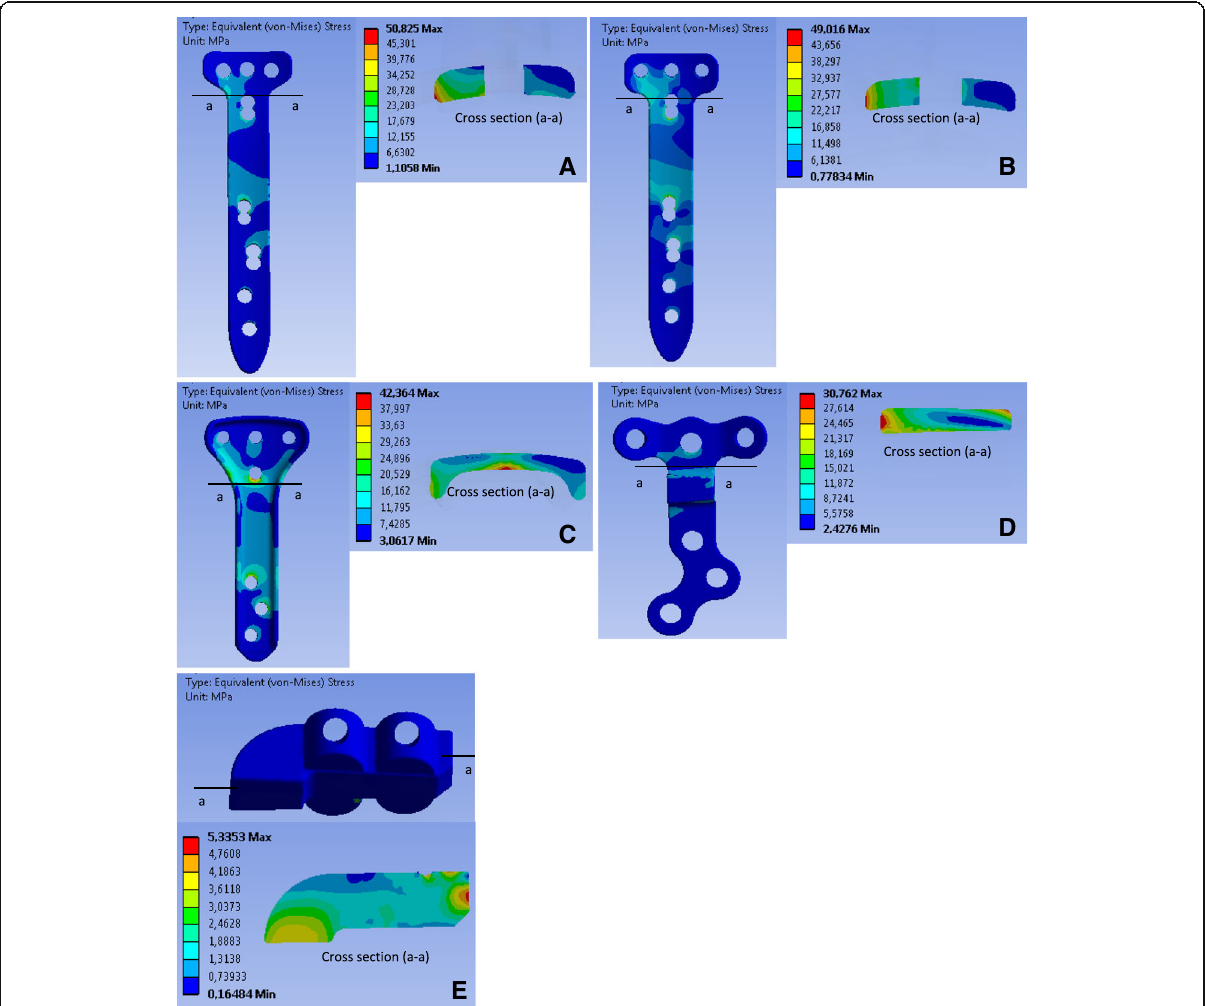
Fig. 7 Equivalent stress (von-Mises) in the implants in position 2:.The letters a, b, c, d and e indicate the TomoFix sm, the TomoFix std., the PEEK Power, the Contour Lock and the iBalance Position 1 – Fig. 6: The maximal von-Mises equivalent stress was located at the plate corner on the right side for all the plates except for the iBalance implant. dle region below the proximal hole, above the wedge, was highly stressed. For the iBalance implant, the highly stressed volume was located in the middle of the im- plant, but on the left side. Position 2 – Fig. 7: As in position 1, the maximal von-Mises equivalent stress occurred, for the Contour Lock and the two TomoFix plates, at the corner on the right side. The margin of the middle region of the PEEKPower plate below the proximal hole above the wedge was the hot spot. The maximal stresses were located at the proximal part of the four other